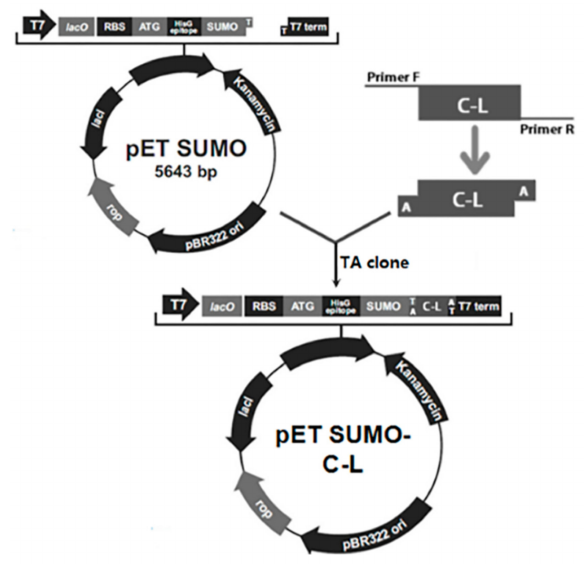
Figure 1. The schematic of construction of expression